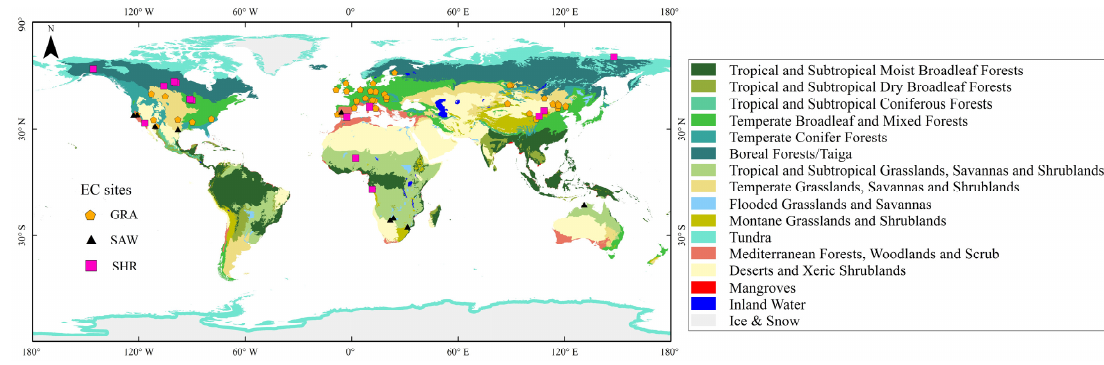
Figure 1. The 68 eddy covariance (EC) flux tower sites used in this study. GRA: grassland; SAW: savanna; SHR: shrubland. The base map is Ecoregion map provided by The Nature Conservancy [54].